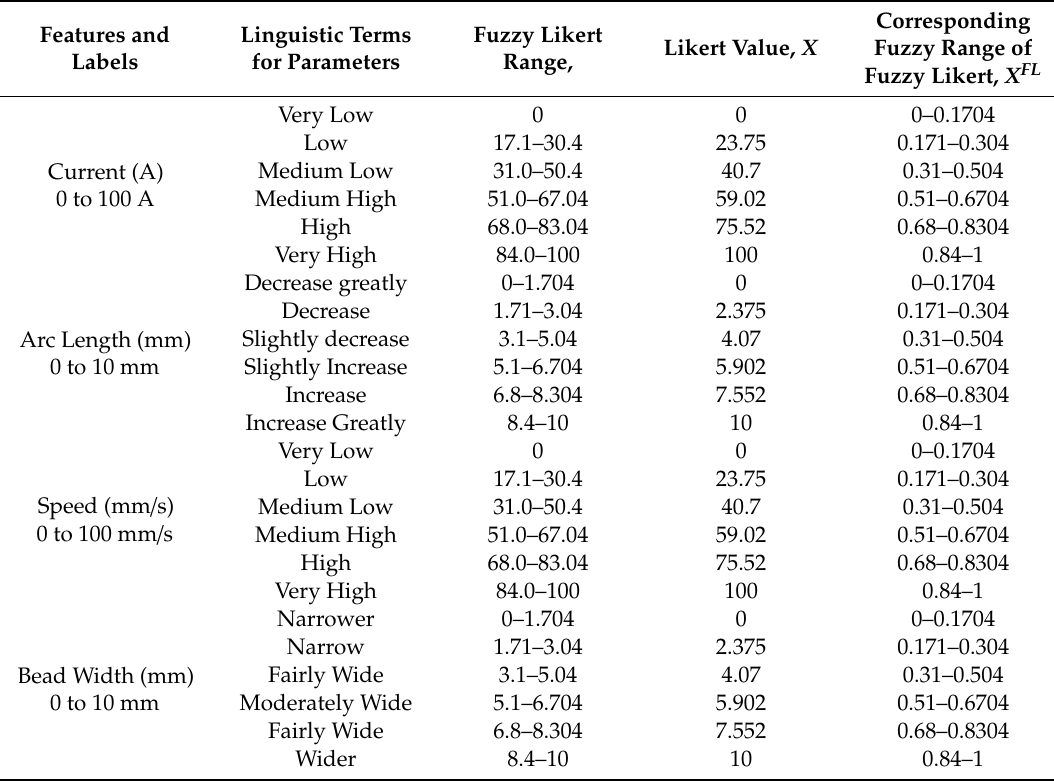
Table 3. Description of features (Control variables) and labels (Outcome), their Likert values and corresponding fuzzy Likert crisp values for degree of